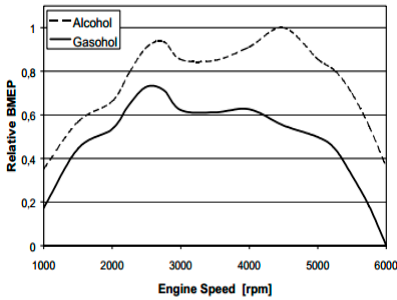
Figure 1. Variation of brake mean effective pressure versus engine speed. Reprinted with permission from Ref. [8]. Copyright (2007) SAE International.